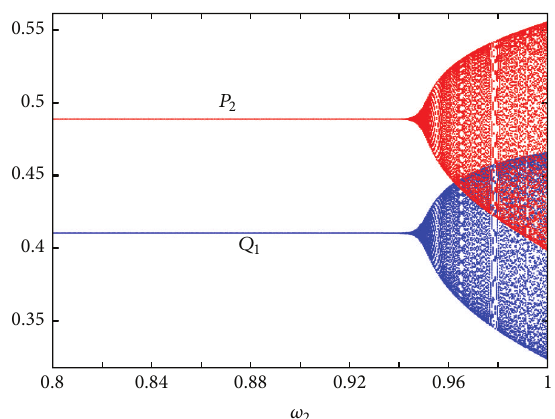
Figure 13: Bifurcation diagrams of system (11) for 𝛼 = 2.5 , 𝛽 = 2.3 , = 1 and 𝜔 0.8 to 1 . 𝜔 1 2 varying from